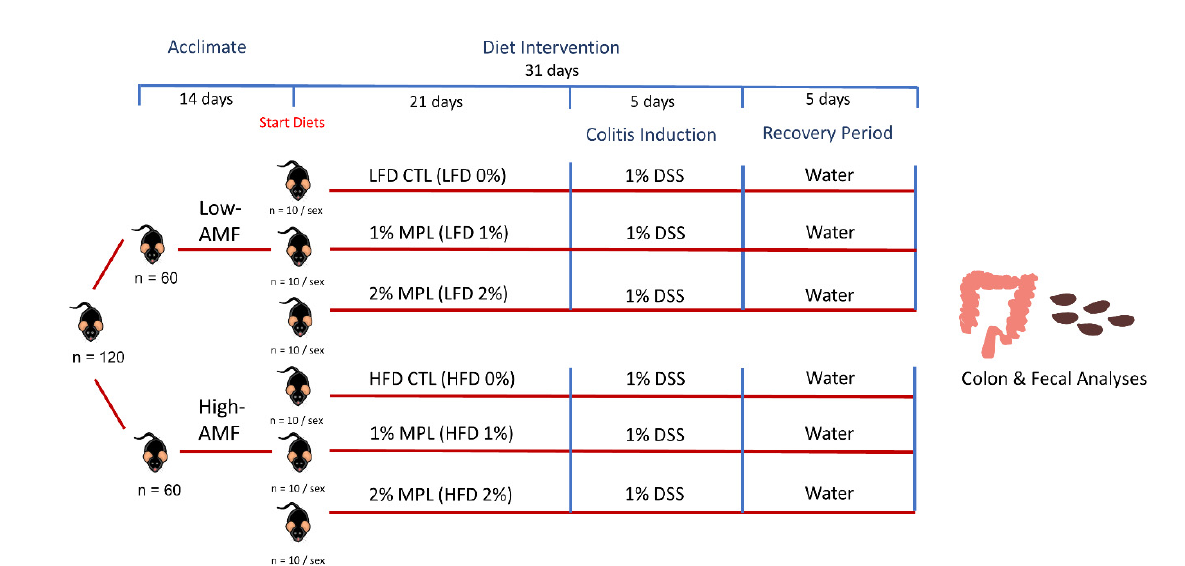
Figure 1. Study Design of Diet Intervention and Colitis Protocol. Male and female C57BL/6J mice (n = 120) were randomized into either a low (5% w/w) milk fat or high (21% w/w) milk fat diet supplemented with either 0%, 1%, or 2% w/w of milk polar lipids (MPL) for three weeks (n = 10/group/sex). Colitis was induced using 1% dextran sodium sulfate (DSS) in drinking water for the next five days and regular drinking water was given for the final five days. Colons were collected for transcriptomics by RNA sequencing, and real-time qRT-PCR, and cecal feces were collected for 16S rRNA sequencing for microbiota analysis. Fecal samples were collected for lipidomics analysis. Disease Activity Index (DAI) was recorded daily consisting of a weight loss, bleeding, and stool consistency score. Abbreviations: AMF, anhydrous milk fat; CTL, control.